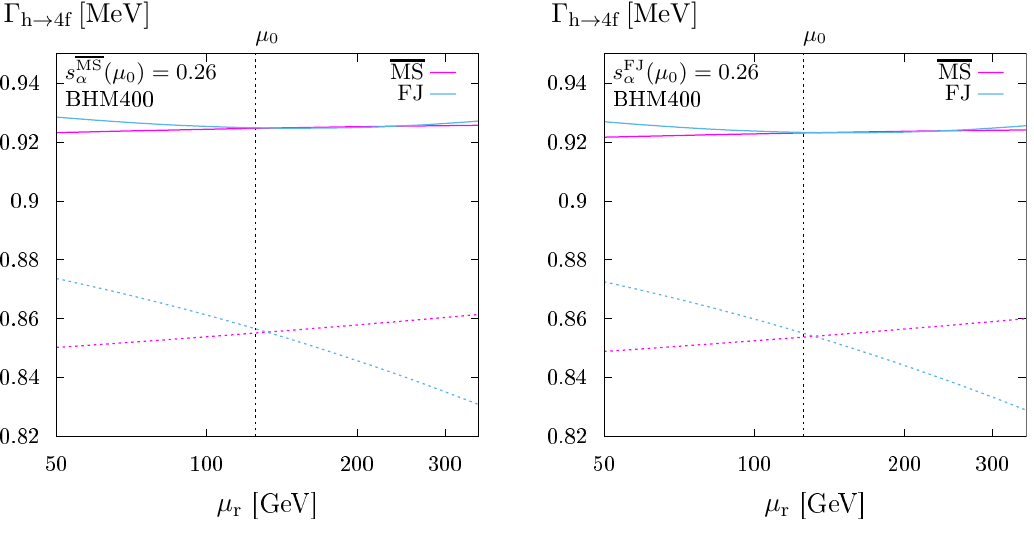
Figure 32 . As in (cid:12)gure 11, but for benchmark scenario